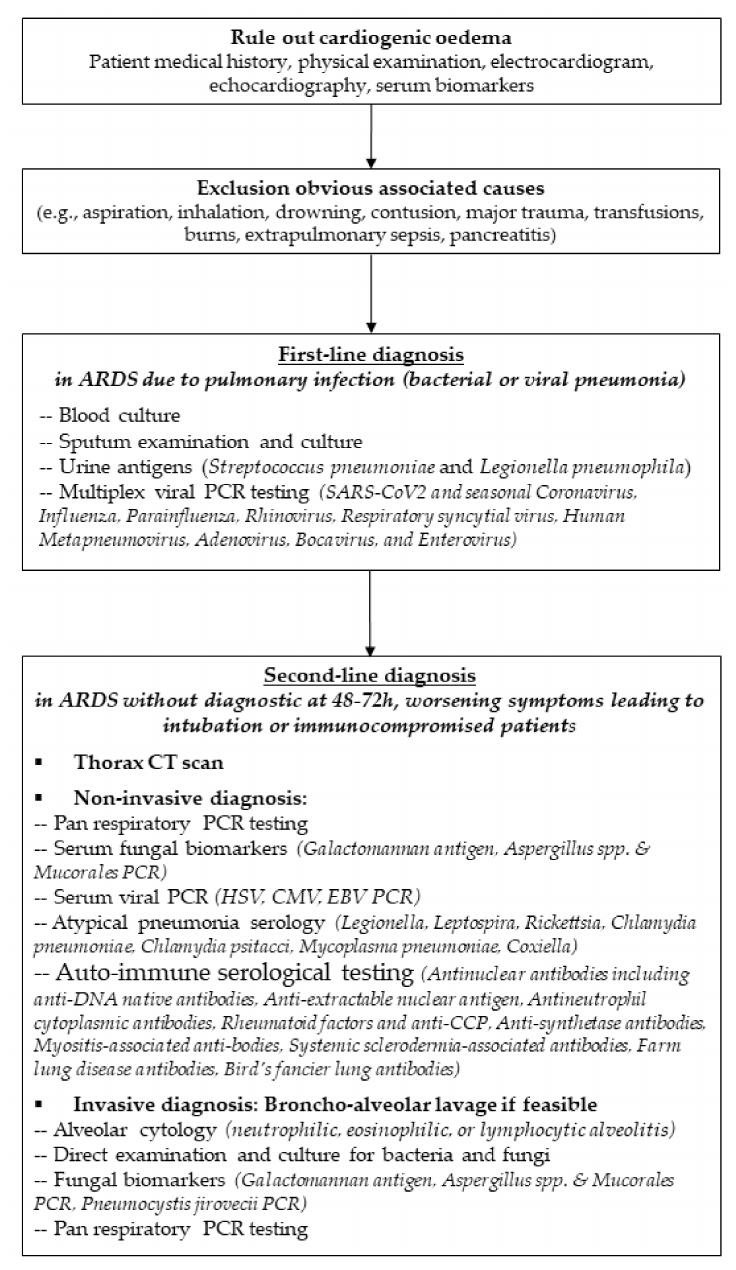
Figure 1. Diagnostic work-up for patients with acute respiratory distress